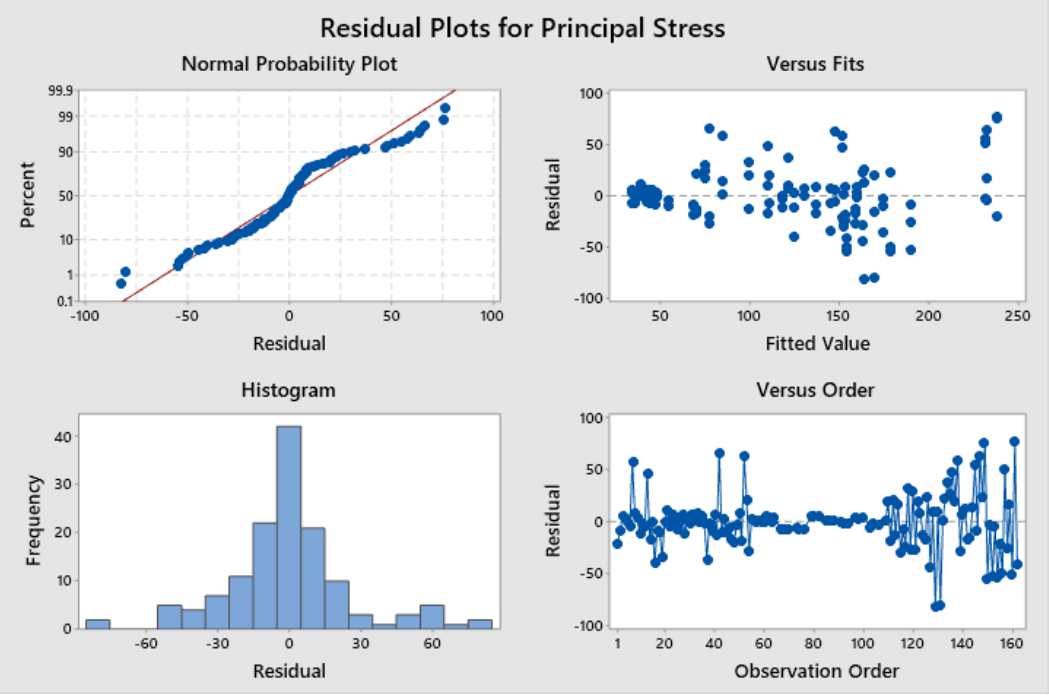
Figure 7. The residual plot of principal stress (two locking screws).